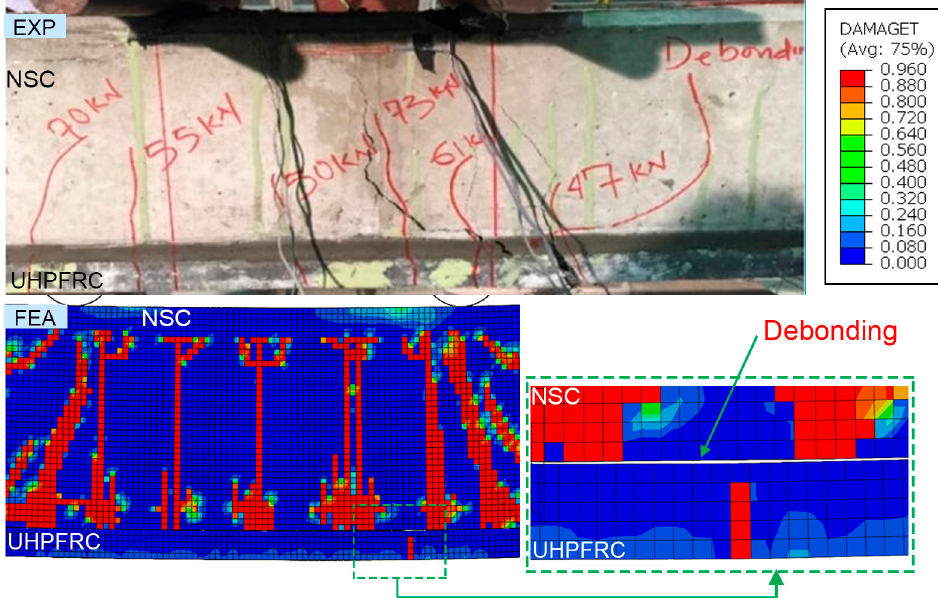
Figure 15. Comparison of the failure of the NSC-UHPFRC specimens between the EXP [36] and FEM simulations for the rough surface in the flexural